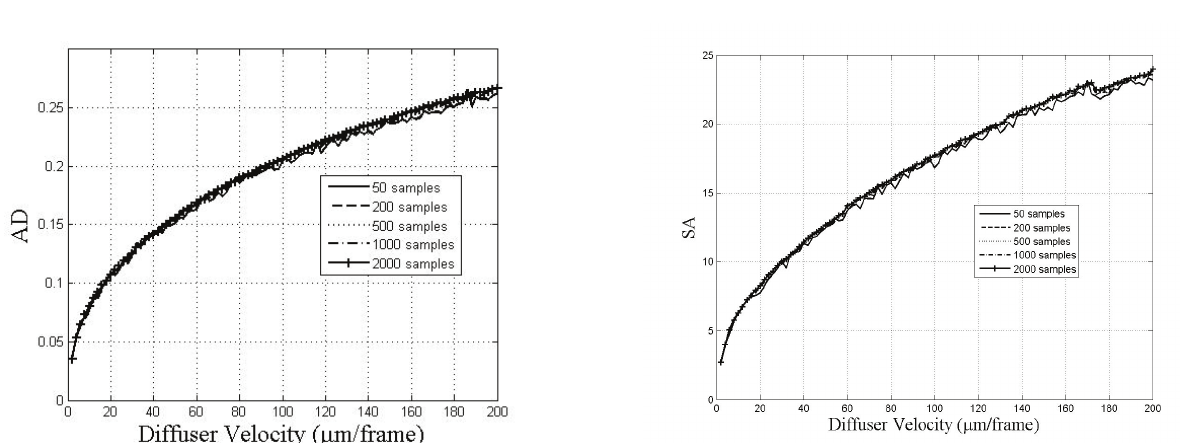
Fig.11 Average Differences descriptor ( AD )